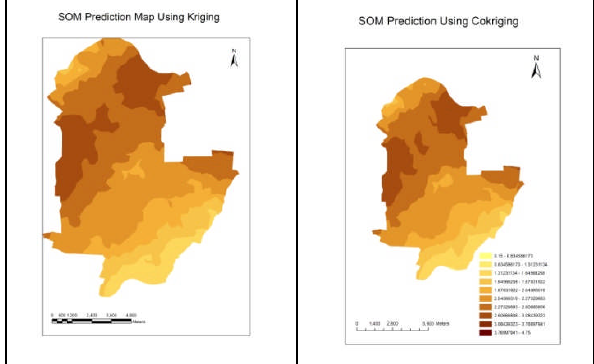
Fig 3: Predicted soil organic matter (SOM) content (%)by kriging and